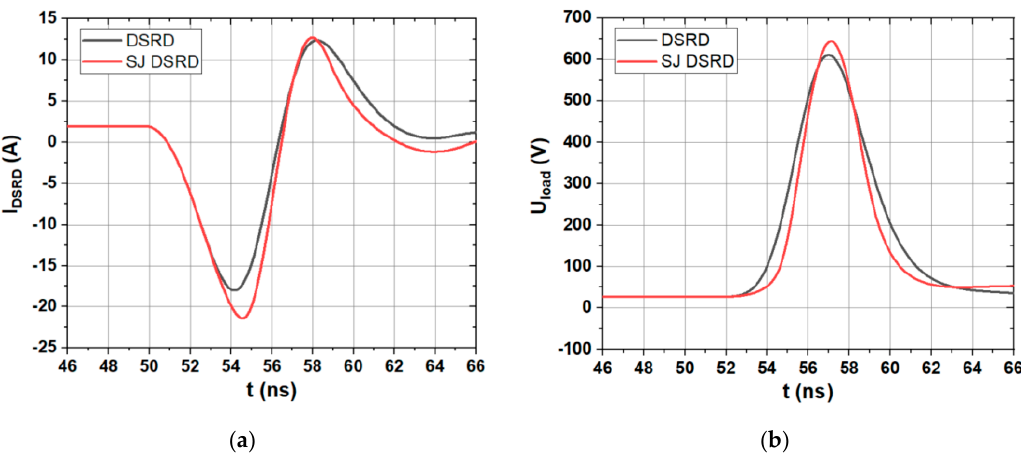
Figure 4. Comparison of ( a ) current waveforms and ( b ) load output voltage waveforms of conventional SiC DSRD and SJ